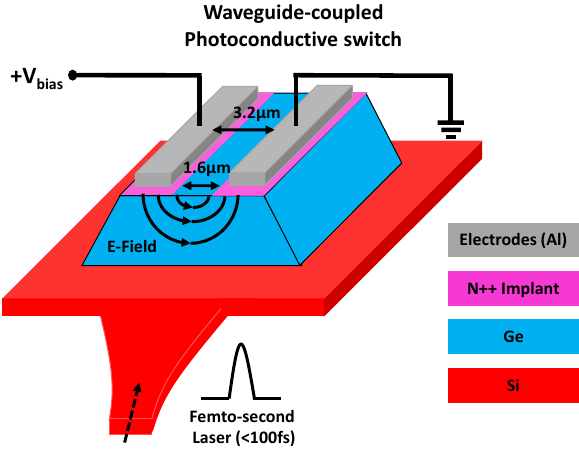
Figure 3. Structure of the proposed waveguide-coupling THz photoconductive switch.